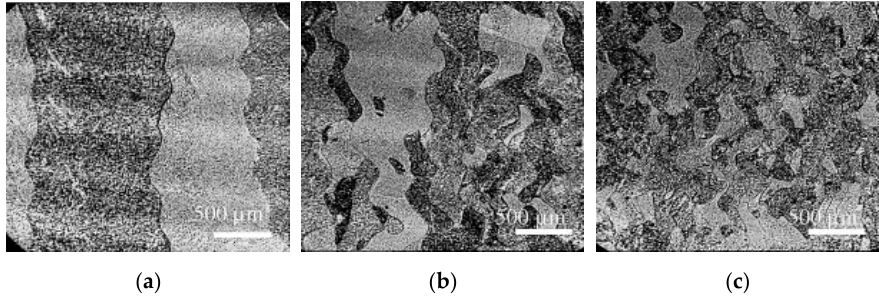
Figure 30. SEM micrograph showing the effect of travel speed on grain dimensions. Travel speeds are ( a ) 300 mm/min, ( b ) 600 mm/min, and ( c ) 900 mm/min (reproduced with permission from [135]; Copyright © 2004 Elsevier).